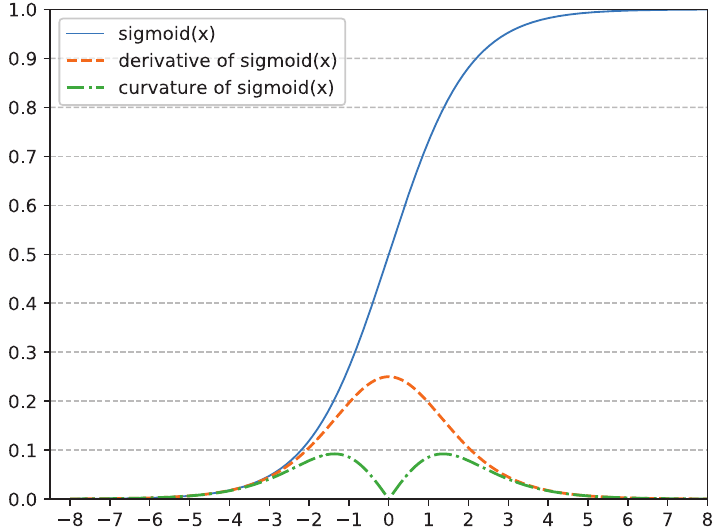
Figure 1. The original, derivative, and curvature graphs of the sigmoid function at the range of [ − 8,